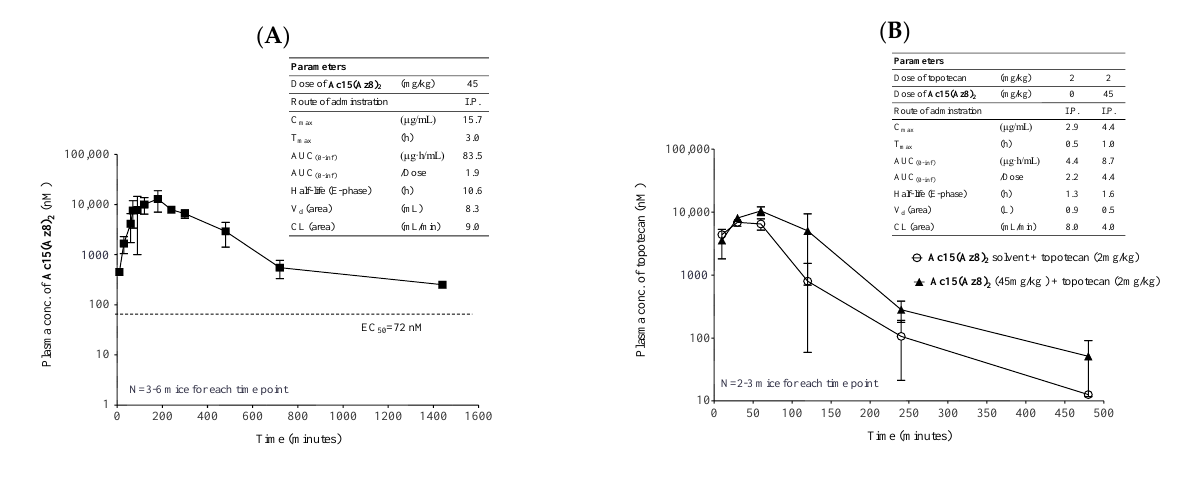
Figure 7. Pharmacokinetics of Ac15(Az8) 2 and its effect on PK of topotecan. ( A ) Plasma concentration of Ac15(Az8) 2 in mice was determined after I.P. injection of 45 mg/kg of Ac15(Az8) 2 . The dash line indicates the EC 50 of Ac15(Az8) 2 (72 nM) for reversing topotecan resistance in S1M180 cell line. ( B ) Plasma concentration of topotecan in mice was determined after I.P. injection of 45 mg/kg Ac15(Az8) 2 or solvent one hour prior to 2 mg/kg topotecan administration (I.P.). PK solutions (PK Solutions TM 2.0.3 software, Summit Research Service) was used to calculate the pharmacokinetic data.